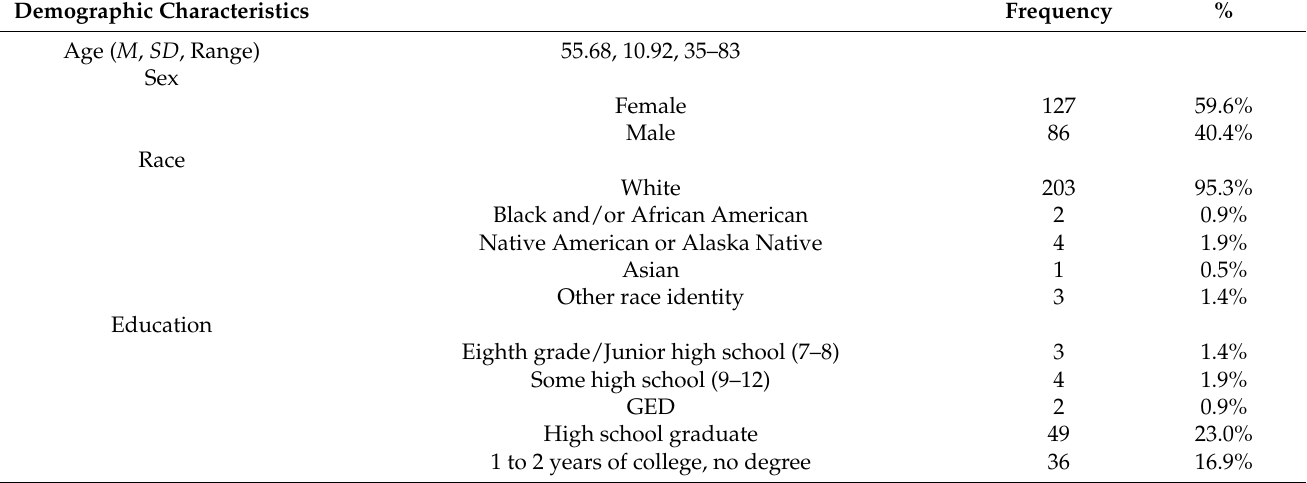
Table 1. Frequency and percentage values of sample characteristics (age, sex, race, education,